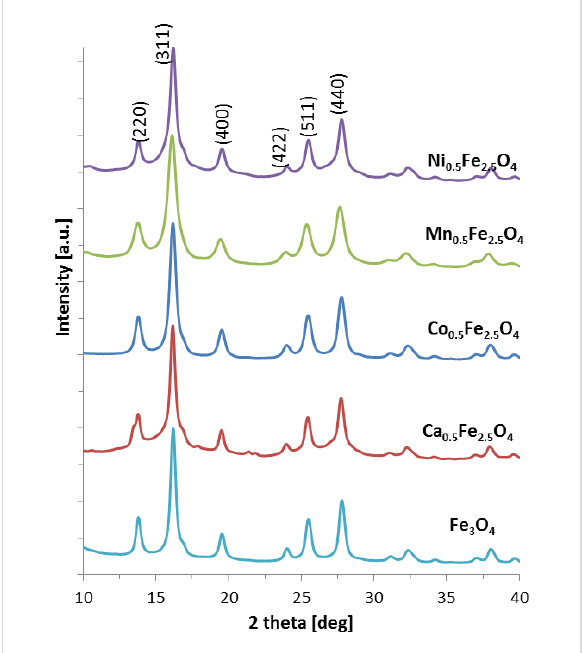
Figure 3: XRD patterns of ferrite nanoparticles.